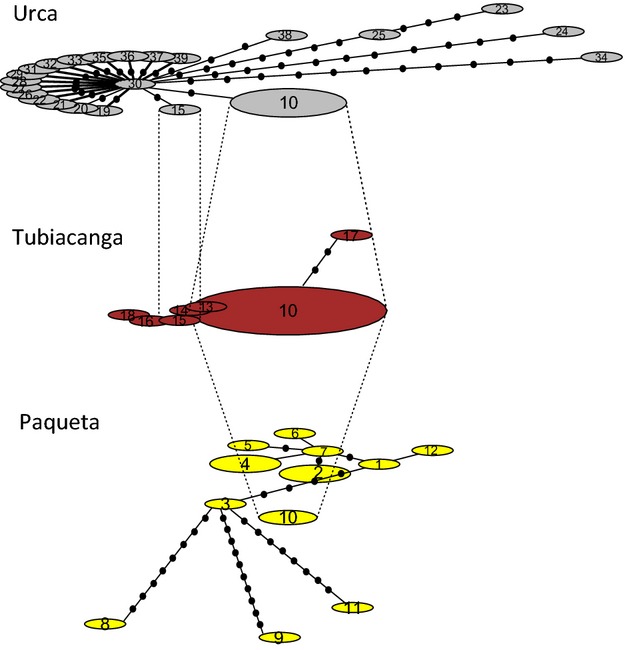
Mitochondrial haplotype network. Haplotype networks in the three localities in Rio. Haplotypes shared among localities are connected by dotted lines.